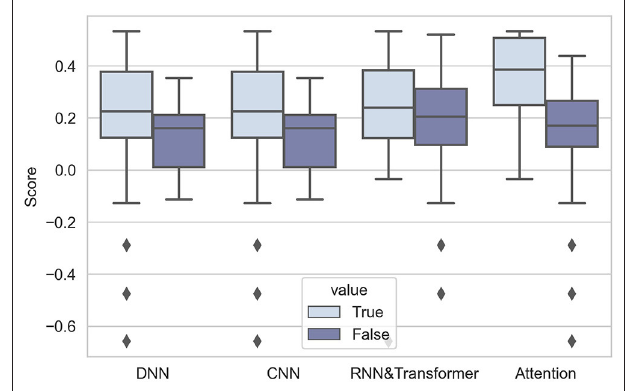
FIGURE 5 | Box-plots of score distributions of machine-learning